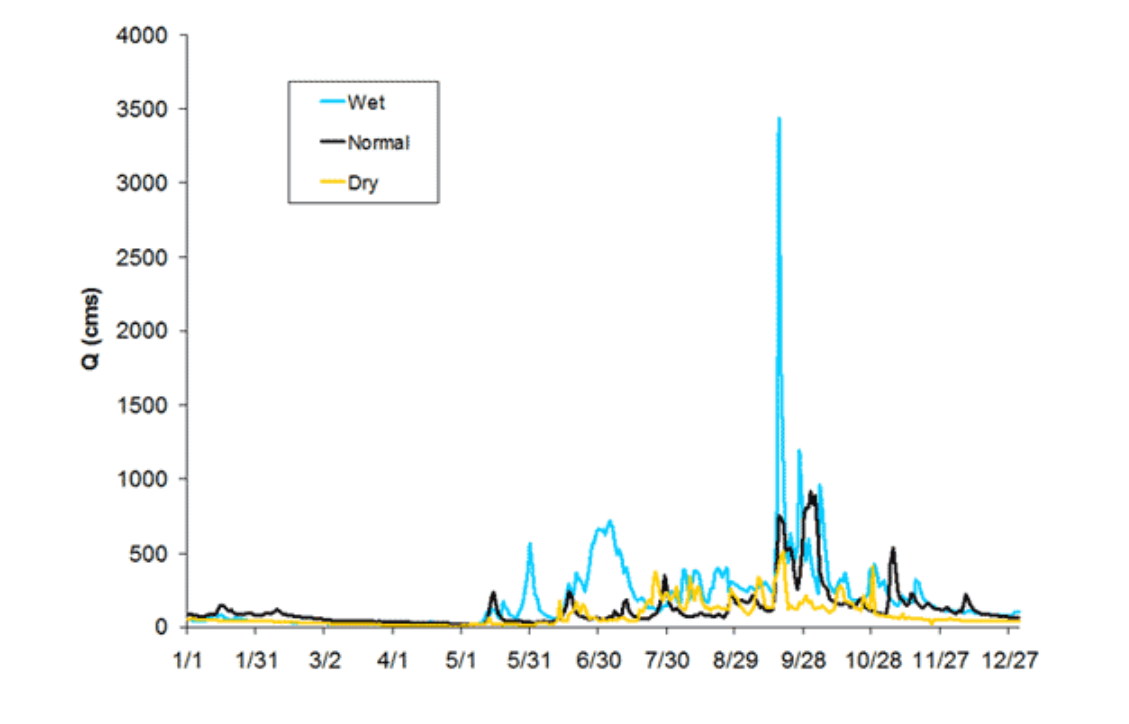
Fig. 2. Representative dry-, normal-, and wet-year hydrographs for the Patuca River at Cayetano, showing the stable low-flow conditions of dry season (January to May), and higher base flow and more variable hydrological conditions of the wet season (June to December). Q = discharge measured in cubic meters per